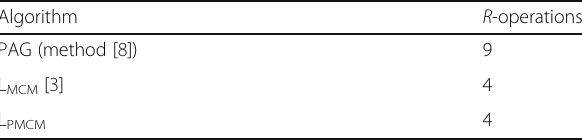
Table 8 Resulting R -operations for Example 5 using n = 2 input adders